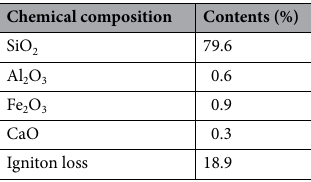
Table 1. Diatomite chemical